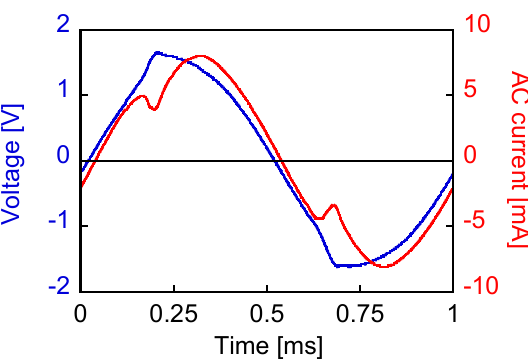
Figure 8. Voltage and current wave when an AC current of 8 mA amplitude was applied (1 kHz).